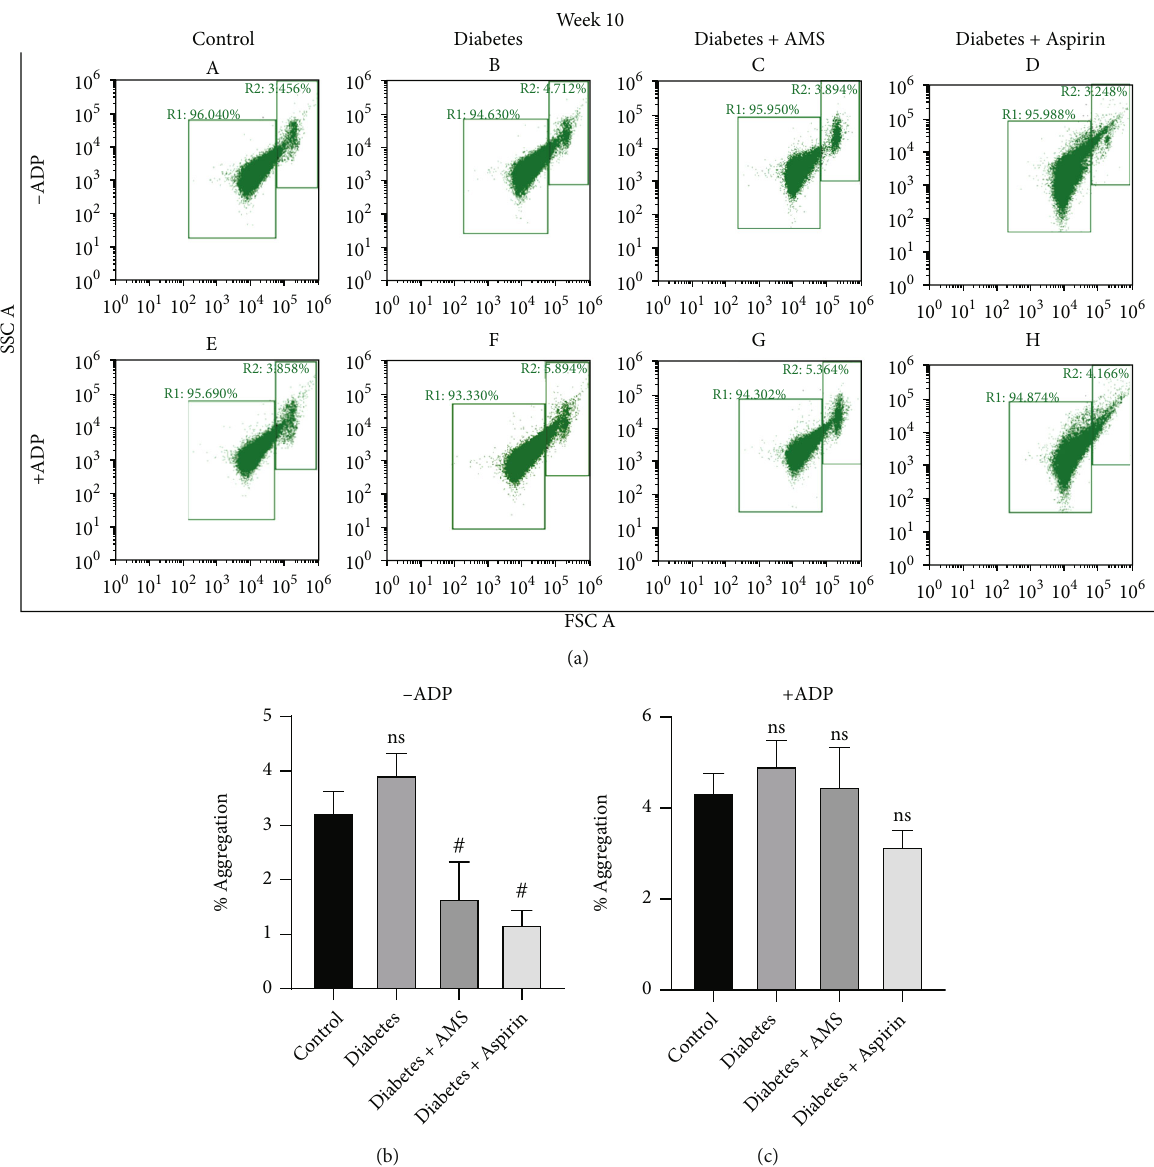
Figure 4: Flow cytometry analysis of platelet aggregation after 10-week treatment. (a) Scatter plot of forward vs. side scatter of platelets from the control (A, E), diabetic (B, F), AMS-treated diabetic (C, G), and aspirin-treated diabetic (D, H) groups, representing percentage of platelet aggregation in the absence and presence of ADP. Bar graph represents percentage of platelet aggregation observed in absence (b) and presence (c) of ADP. All values are represented as mean ± SEM ( N = 3 ). # p < 0 : 05 vs. diabetes; ns: nonsigni fi